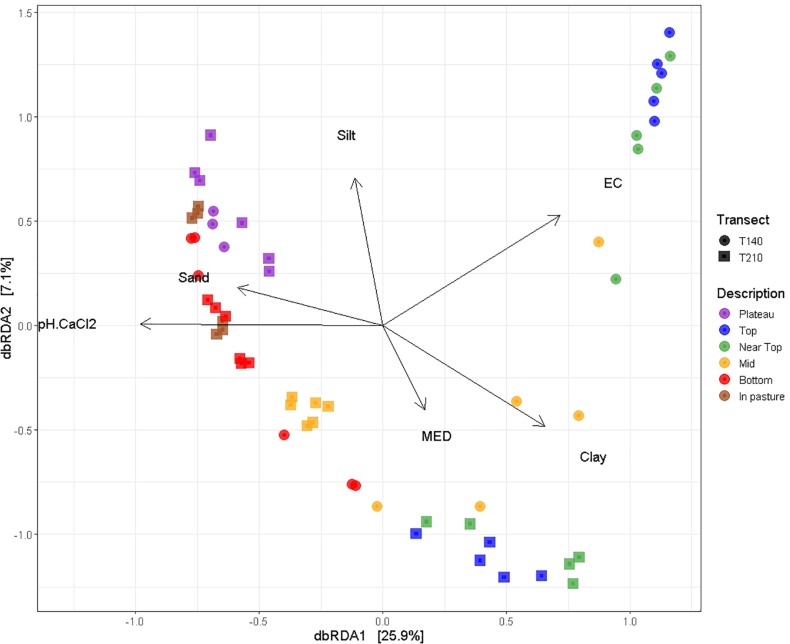
dbRDA ordination plot using unweighted UniFrac distance matrices with environmental variables (pH, EC, MED, and soil texture) mapped on using the envfit function (vegan package in R). Both the first (P = 0.001) and second (P = 0.001) dbRDA axes significantly explained the variation in the bacterial community composition.